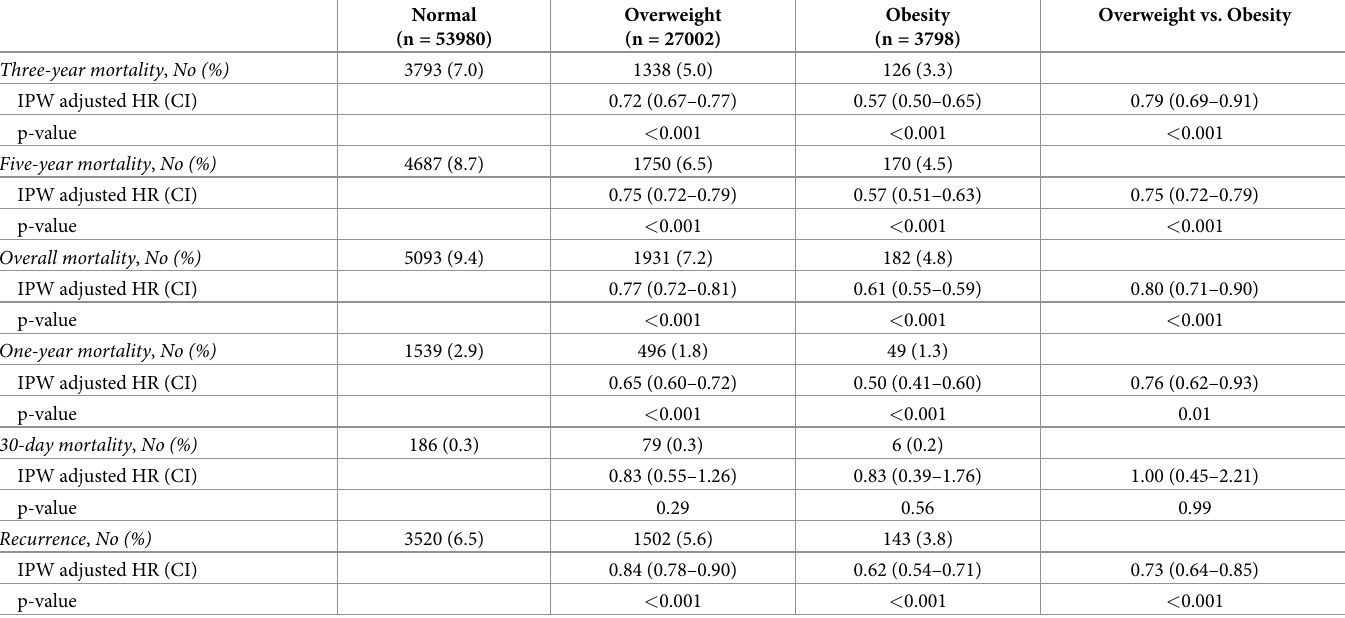
Table 3. Mortalities and recurrence rate of the normal, overweight and obesity groups.